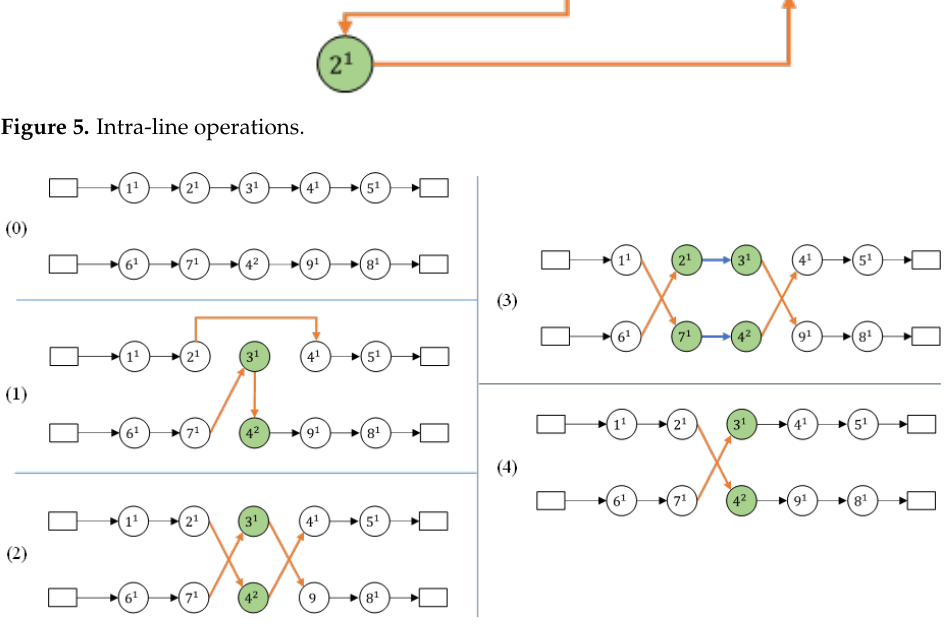
Figure 6. Interline operations. Figure 6. Interline